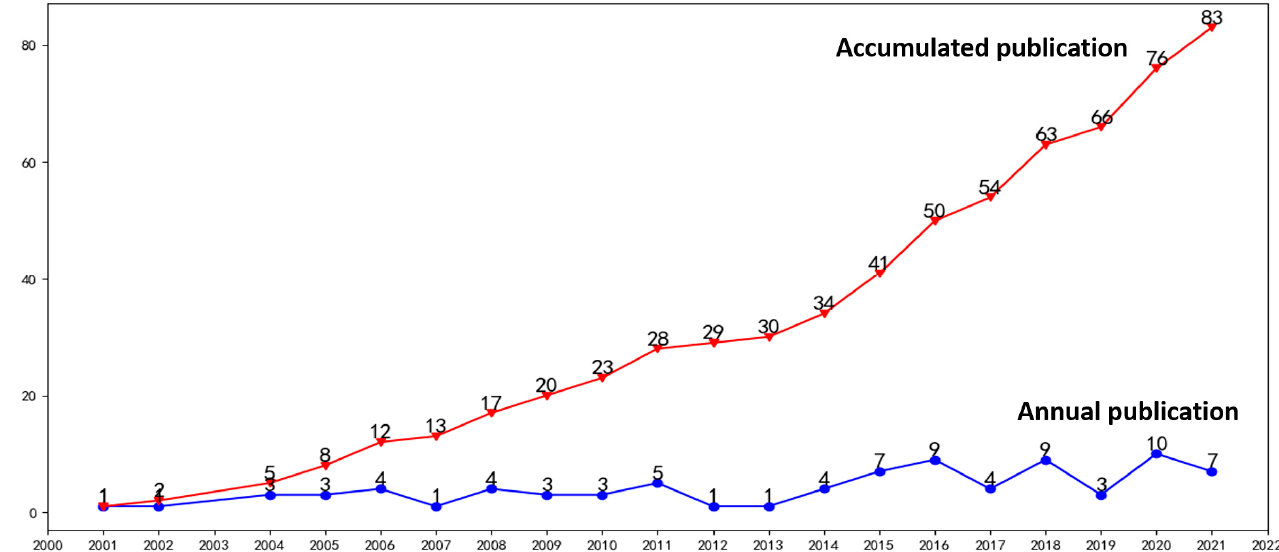
Figure 1. Annual and accumulated publications from 1993 to 2021 found in the Web of Science in a search about electrochemical techniques for the detection and analysis of GM crops.